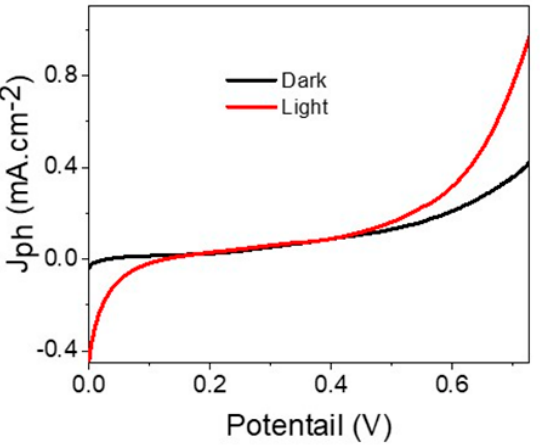
Figure 6. The relation between the voltage and current density for the flexible PET/ITO/MoS 2 photoelectrode.